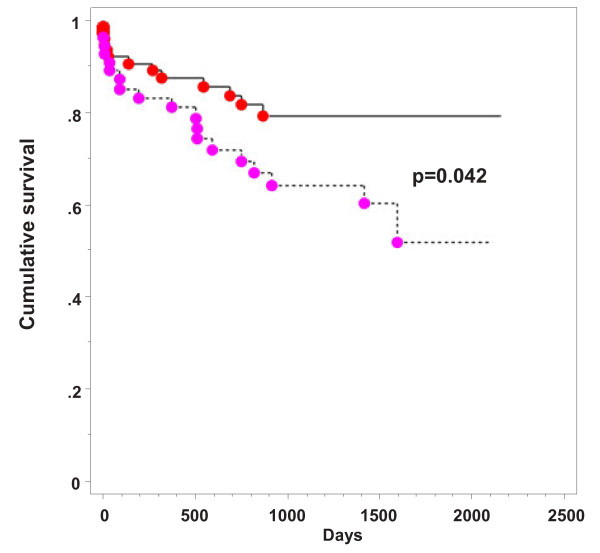
Kaplan–Meier analysis with log rank test. There was a significantly lower cumulative 1-year survival in the group with transfusion of more than four RBCs (dashed line). RBC, red blood cell.